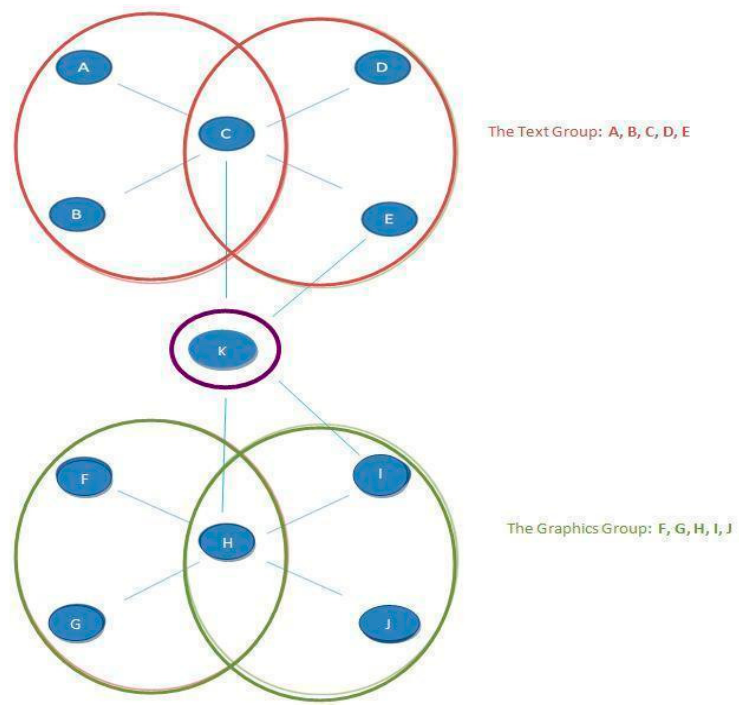
Figure 4. Study 4—Depiction of a brokerage network.